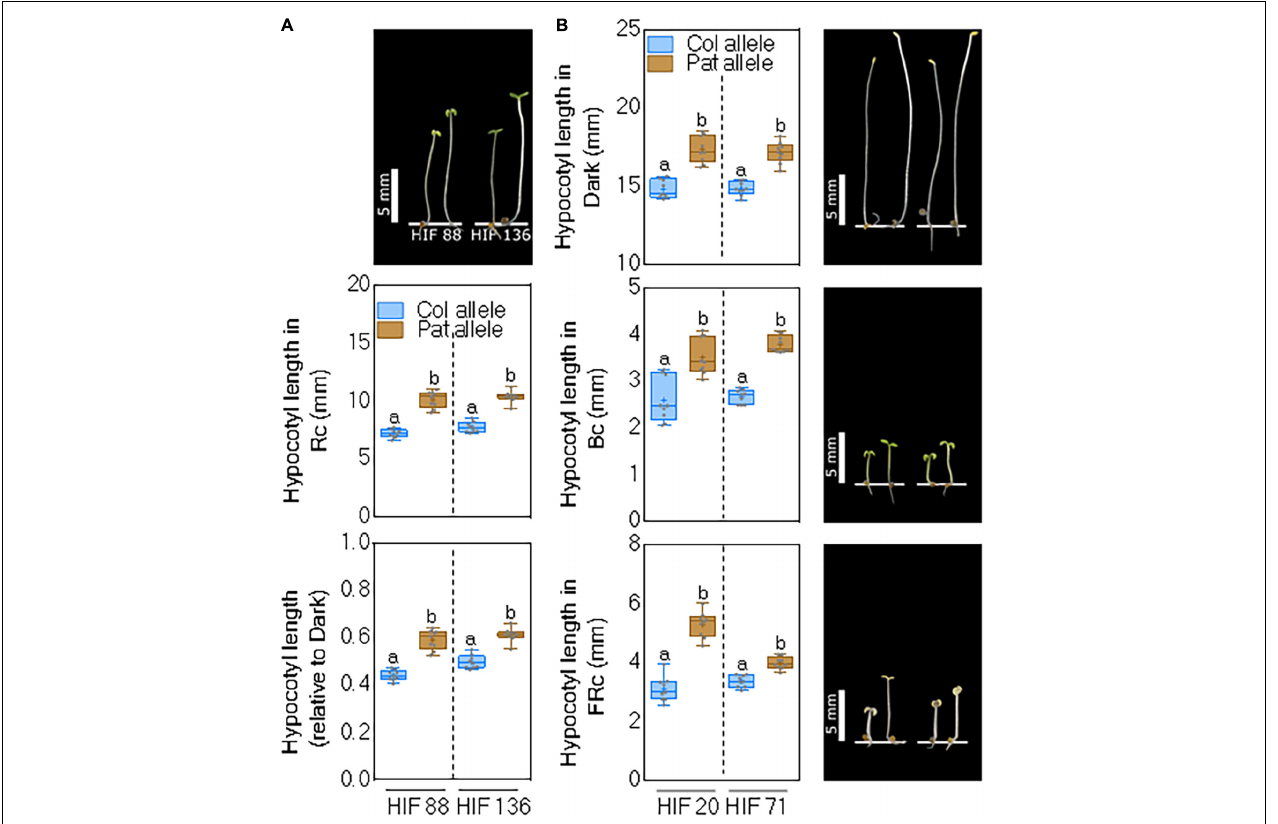
FIGURE 4 | Rc1 and Bc1 QTL confirmation by two independent HIFs. (A) Hypocotyl length for seedlings grown in Rc and Rc/dark of two independent HIF88 and HIF136 segregating as Col-0 and Pat alleles at the Rc1 QTL. (B) Hypocotyl length for seedlings grown in dark, Bc, and FRc in two independent HIF20 and HIF71 segregating as Col-0 and Pat alleles at the Bc1 QTL. Box and whisker diagrams depict data around the median, while distinct letters indicate significant differences between means analyzed by LSD test ( p -value < 0.05). Photos show representative seedlings in each light trait for HIFs segregating as Col-0 (left) and Pat